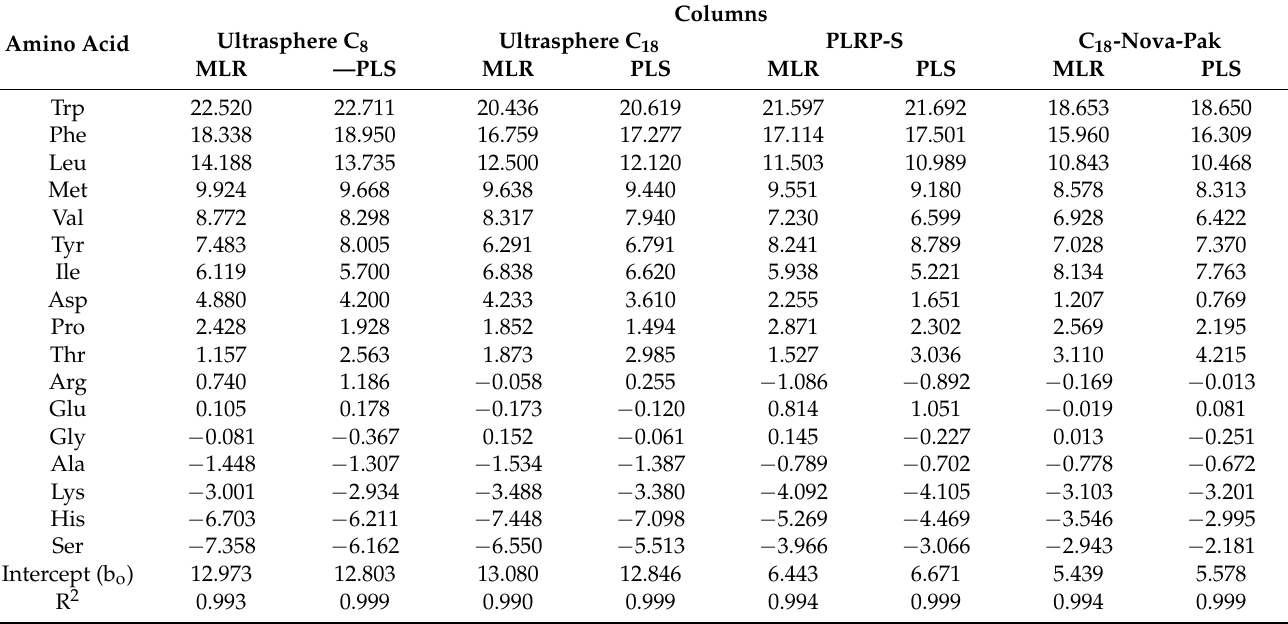
Table 2. Retention time coefficients of amino acids